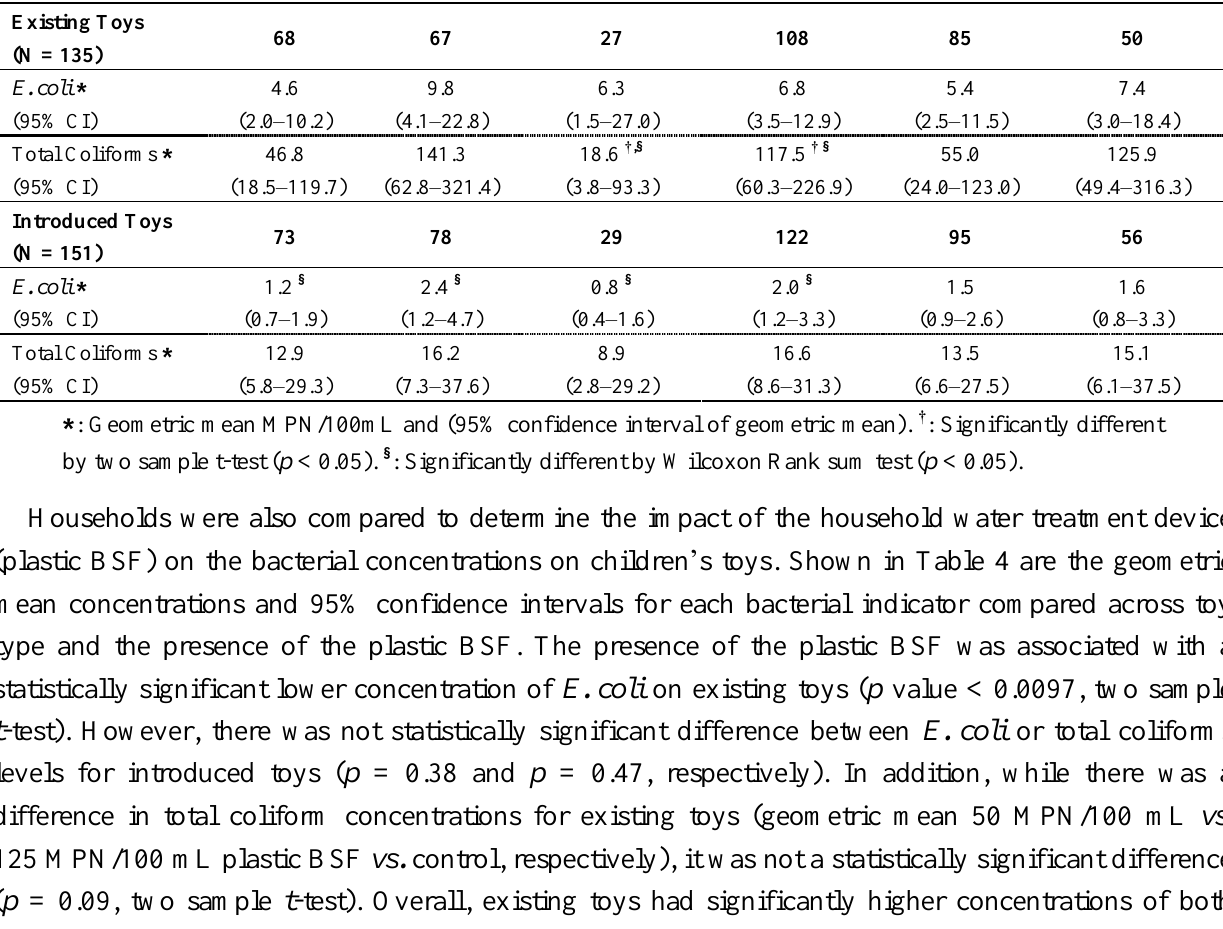
Table 3. Comparison of bacterial levels on existing toys and new toys introduced for two weeks from households with improved or unimproved water and sanitation conditions during a trial of the plastic biosand filter in Copan, Honduras. Improved Lack Improved Improved Lack Improved Latrine No Latrine Sanitation Sanitation Water